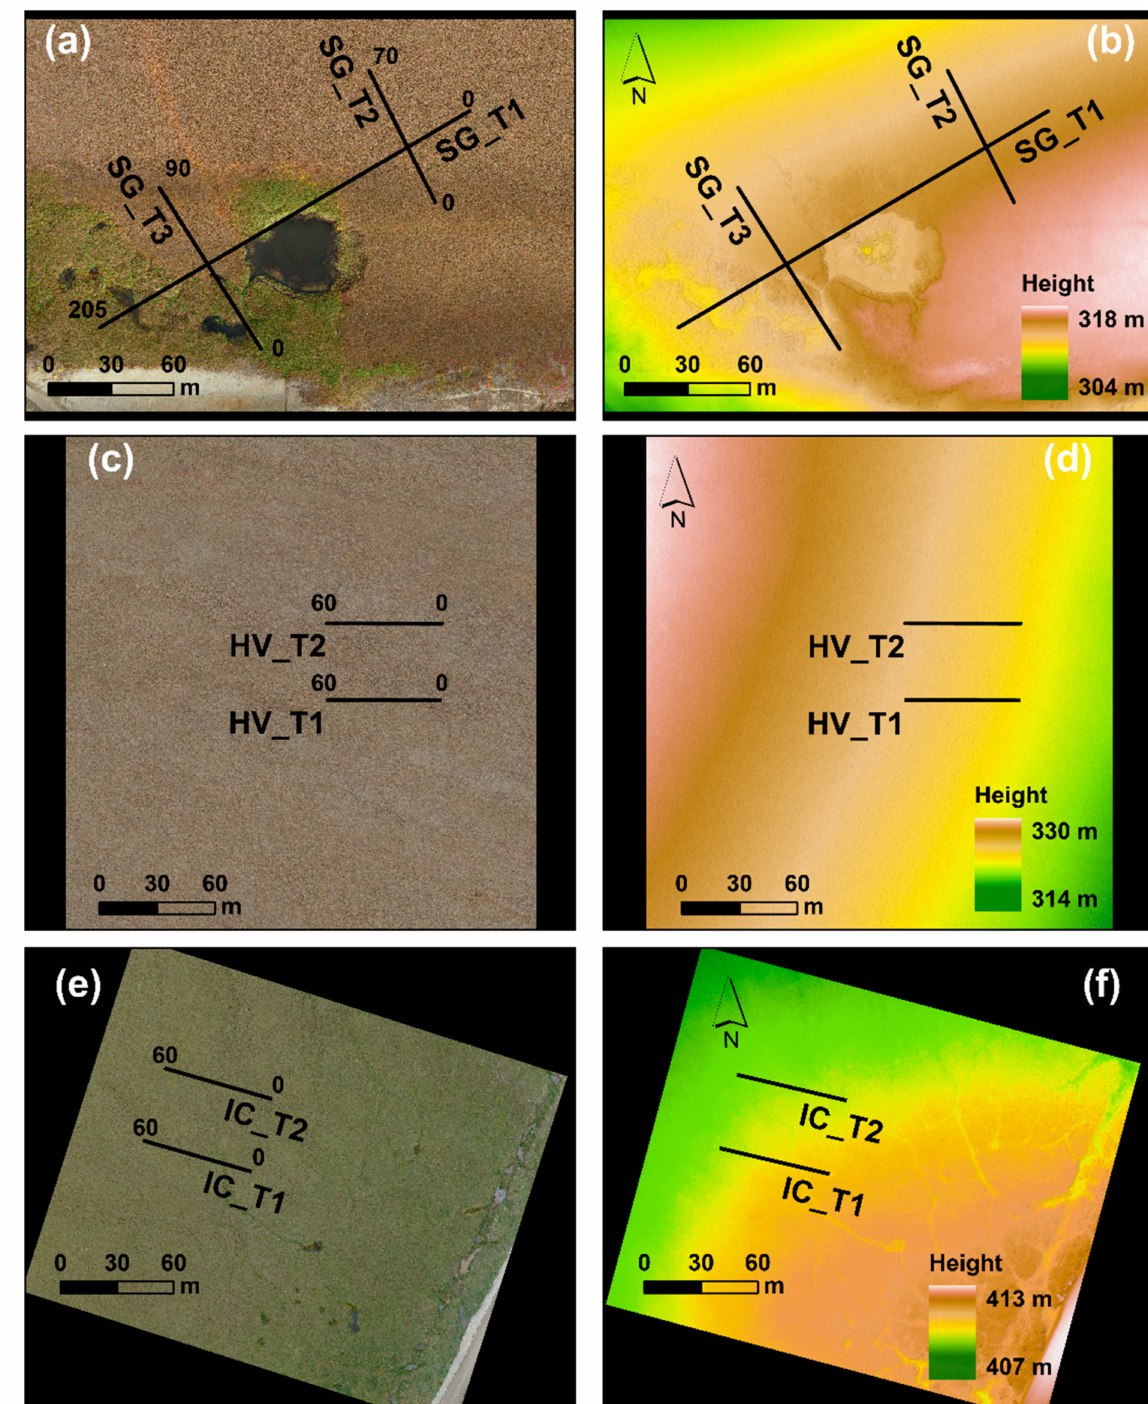
Figure 2. Locations of survey transect lines at the ( a , b ) SG (Sagwon), ( c , d ) HV (Happy Valley), and ( e , f ) IC (Ice Cut) sites. ( a ) Red/green/blue (RGB) images ( a , c , e ) and digital surface models (DSMs) ( b , d , f ) for sites SG, HV, and IC were obtained using a UAV (DJI Matrice M210 with Zenmuse X4s) and processed (Agisoft Metashape v. 1.6.3) by the Toolik Field Station GIS (geographic information system) and Remote Sensing Department using an unmanned aerial vehicle (DJI Matrice M210 with Zenmuse X4s). The numbers at the beginning and end of the transect lines indicate the start point (0) and length of the transect in meters, respectively. Field photos are available in Appendix